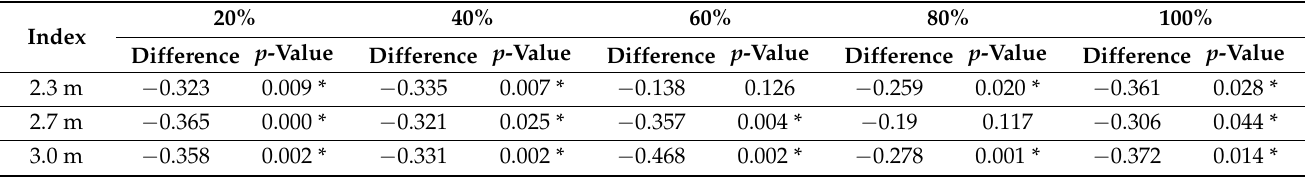
Table 5. Analysis of difference between ceiling height and window ratio RAB indicators of aspect ratio A.